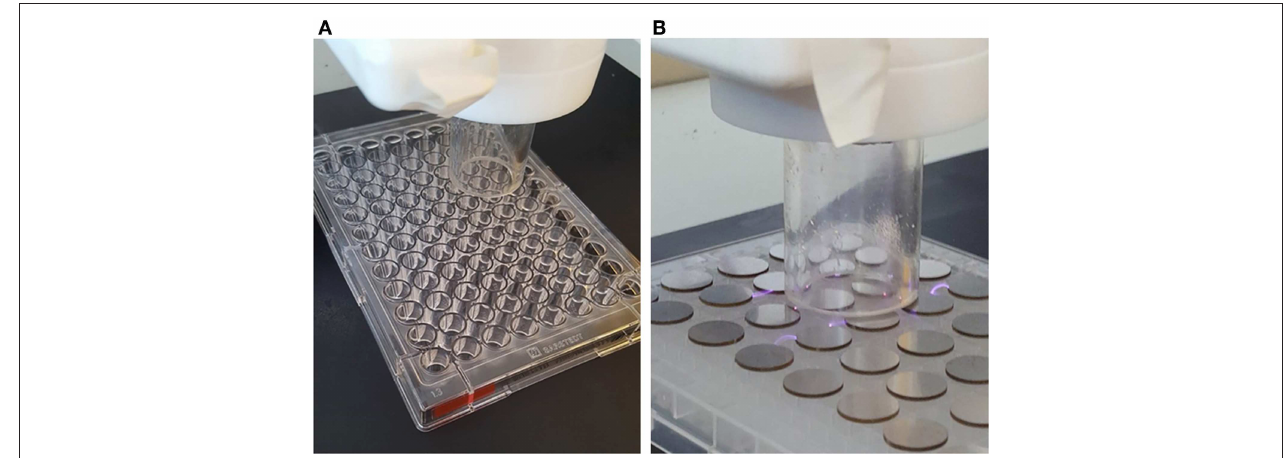
TABLE 2 | Tests with solutions containing gentamicin released from the plasma deposited steel coupon into PBS and MHB. Suspension Planktonic cells Biofilm testing Coupons in PBS Coupons in MHB Coupons in PBS Coupons in MHB –